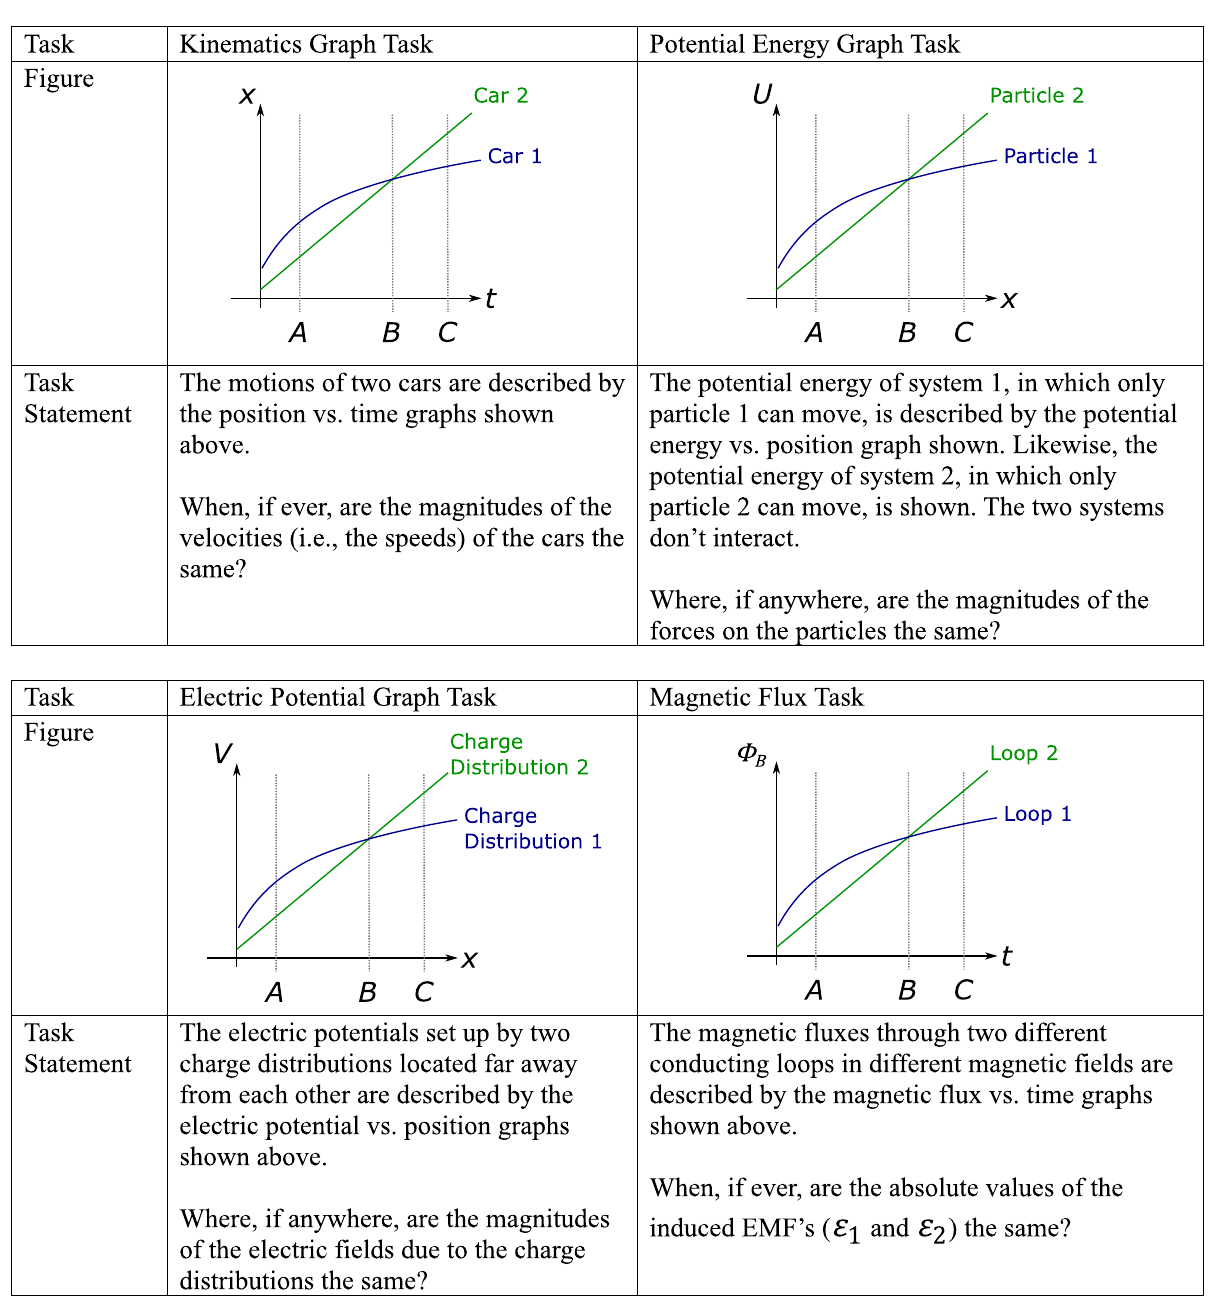
FIG. 7. Tasks statements from the four isomorphic graph tasks used in the